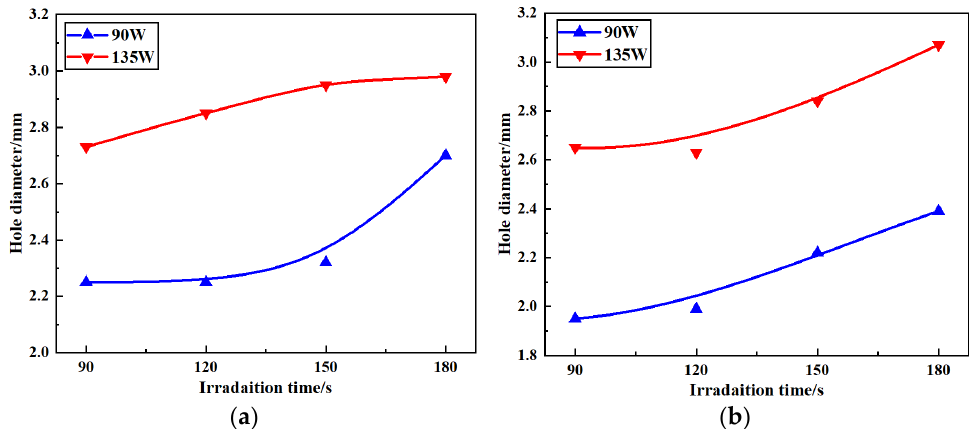
Figure 5. Variation of hole diameter with irradiation time under different conditions ( a ) dried sample; ( b ) soaked sample.